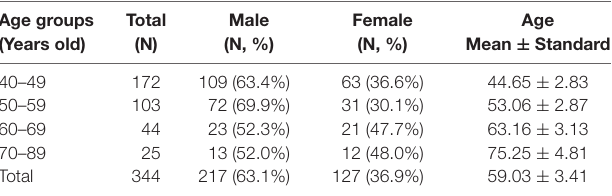
TABLE 1 | Descriptive statistics of the subjects in this